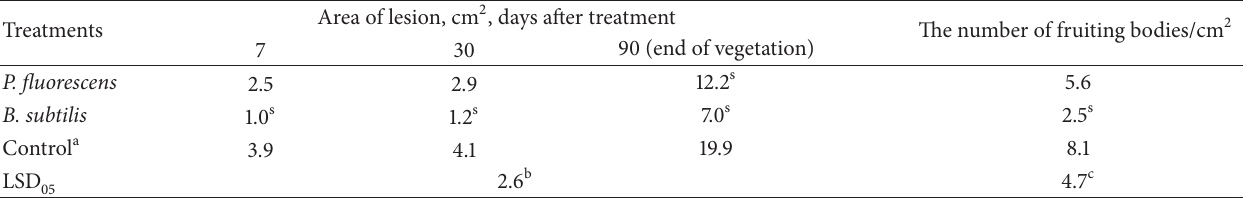
Table 3: Influence of the biocontrol agents on cane lesion due to spur blight development in inoculation experiment with D. applanata in cultivar Kirzhach. Treatments